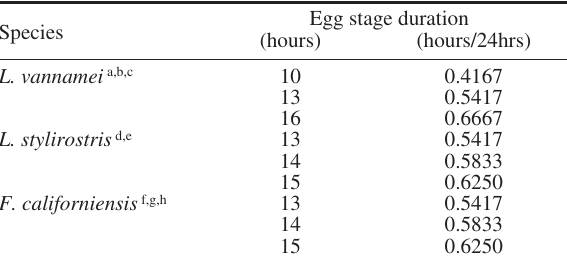
Table 3. – Duration of the egg stage reported for the white ( L. van- namei ), blue ( L. stylirostris ), and brown ( F. californiensis ) shrimps in the Mexican Pacific.